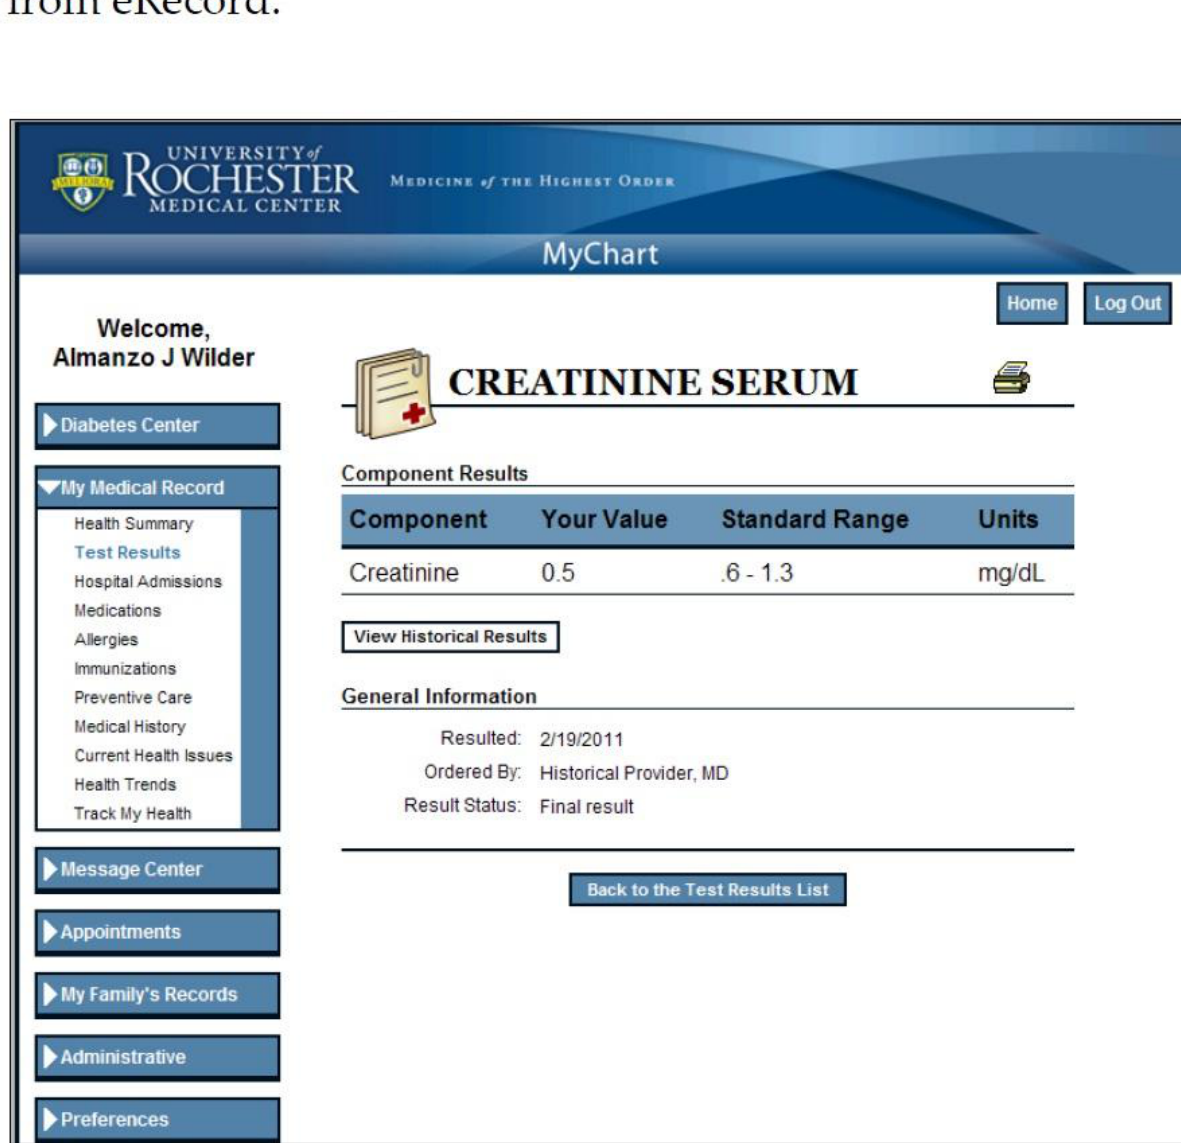
Figure 1. Test results in personal health